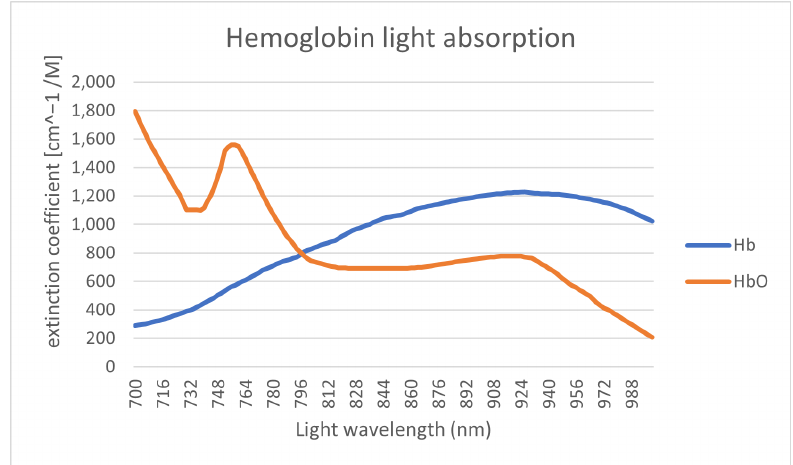
Figure 4. Oxygenated and de-oxygenated hemoglobin light absorption